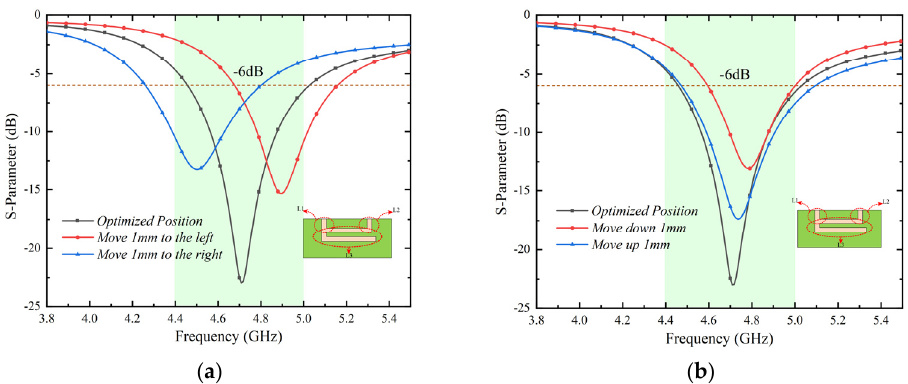
Figure 6. Simulation results with L1 and L2. ( a ): The reflection coefficients obtained after moving the feeding line to the left and right, respectively, and ( b ): the reflection coefficients obtained after moving the feeding line up and down, respectively.